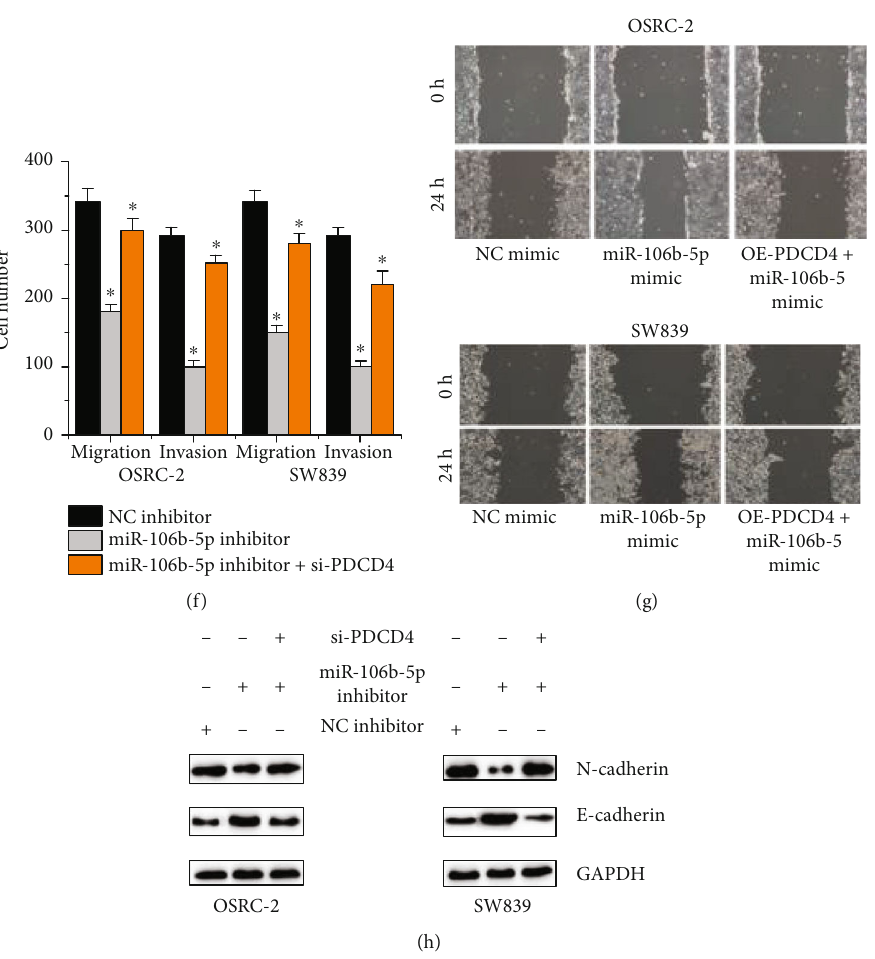
Figure 3: PDCD4 mediates miR-106b-5p-dependent ccRCC cell migration and invasion. (a) The predicted binding sites between miR- 106b-5p and PDCD4. (b) The dual luciferase reporter assay detects the luciferase activity of PDCD4-WT/PDCD4-MUT in OSRC-2 and SW839 cells cotransfected with miR-106b-5p mimics. (c) The relation of the miR-106b-5p expressions and PDCD4 expressions in renal cancer. (d) Western blot determines the PDCD4 expressions in OSRC-2 and SW839 cells transfected with miR-106b-5p mimics and miR-106b-5p inhibitor. (e, f) Transwell assay detects migration and invasion abilities OSRC-2 and SW839 cells transfected with NC inhibitor, miR-106b-5p inhibitor, si-PDCD4, and miR-106b-5p inhibitor. (g) Wound healing detects migration abilities of OSRC-2 and SW839 cells transfected with NC mimic, miR-106b-5p mimic, OE-PDCD4, and miR-106b-5p mimic. (h) Western blot analyzes the expressions of E-cadherin, N-cadherin in OSRC-2, SW839 cells transfected with NC inhibitor, miR-106b-5p inhibitor, si-PDCD4, and miR-106b-5p